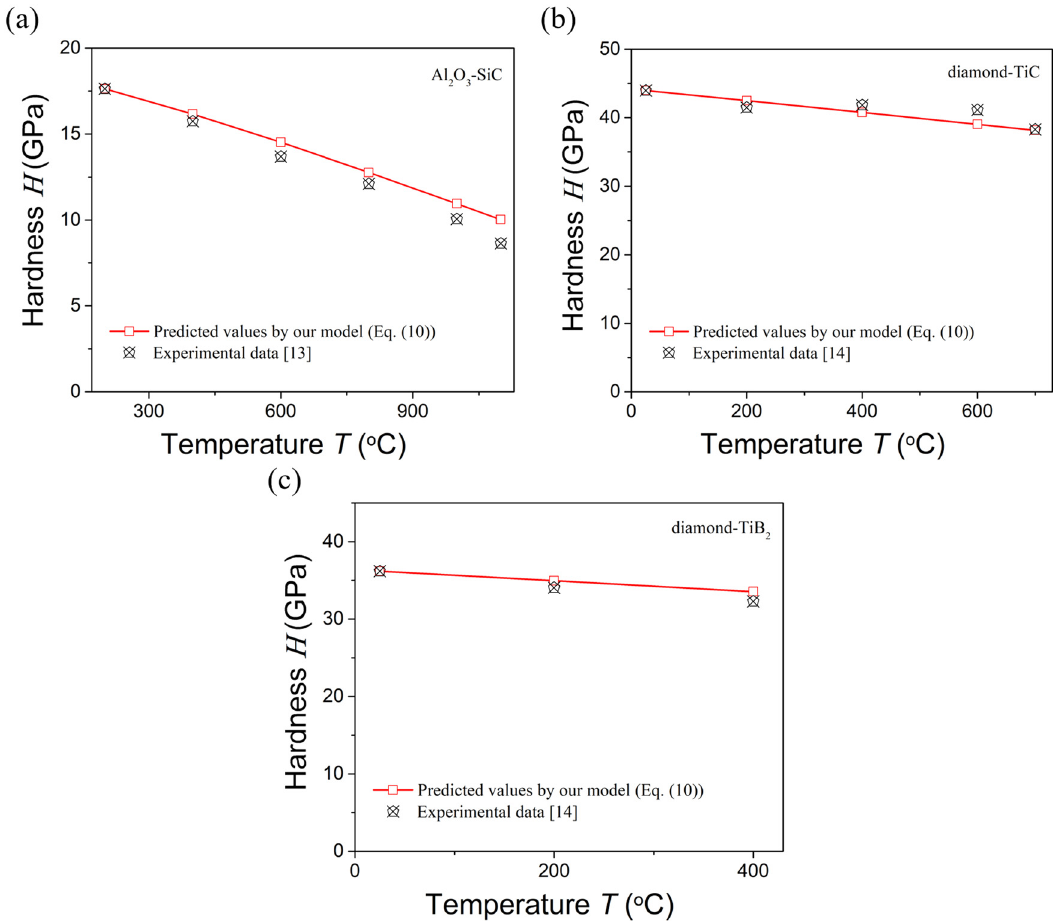
Figure 4: Comparison between the model - predicted and measured hardness of some ceramic composites at high temperature: ( a ) Al – SiC, ( b ) diamond – TiC, ( c ) diamond – TiB 2 O 3